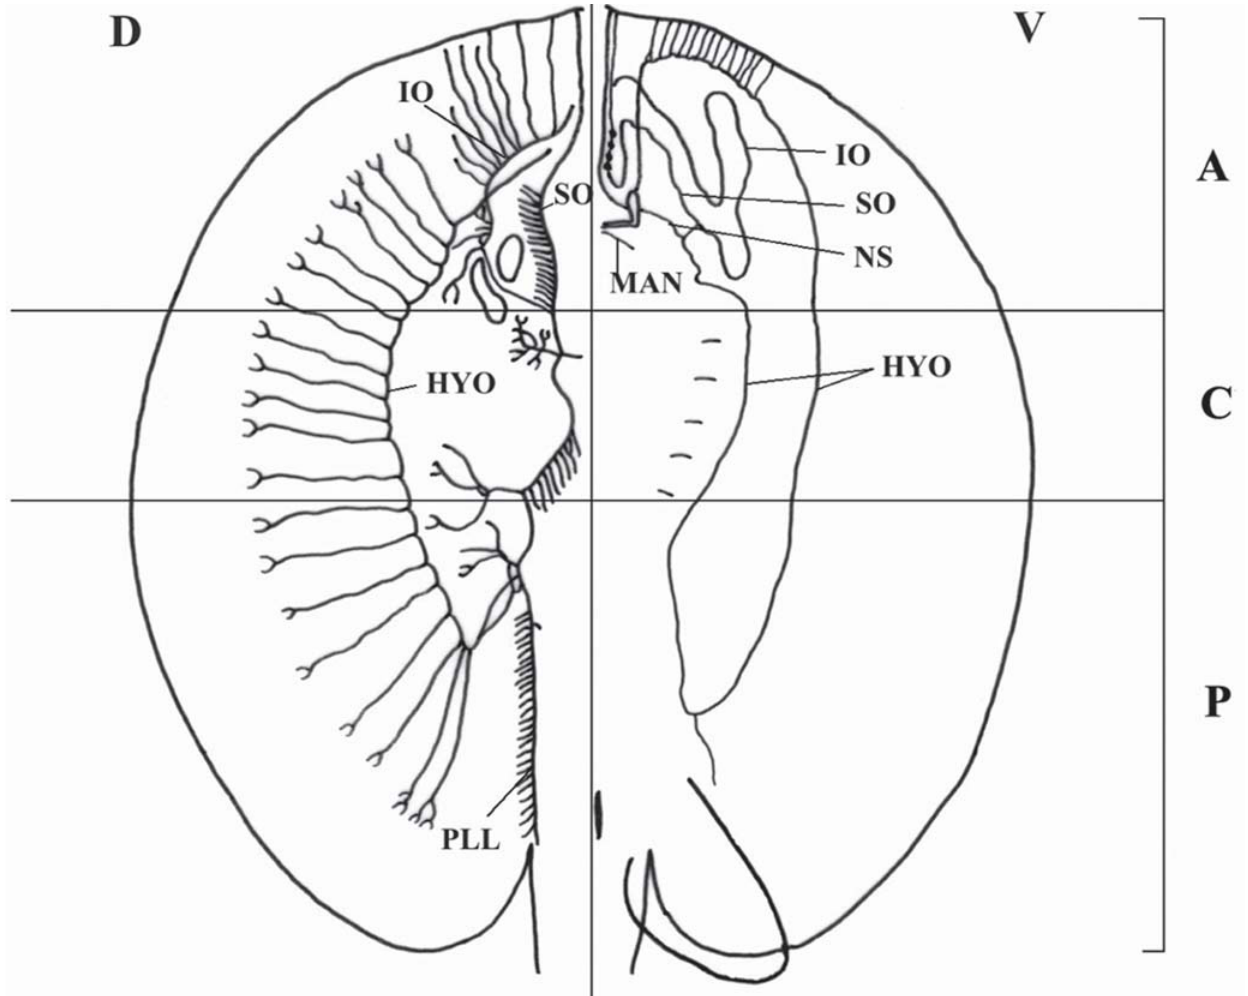
Fig. 2. Lateral line canals on the dorsal (D) and ventral (V) surfaces, divided in three sections to quantify neuromasts in Potamotrygon motoro and P . orbignyi . A) anterior; C) central, and P) posterior. HYO) hyomandibular canal; IO) infraorbital canal; MAN) mandibular canal; NS) nasal canal; PLL) posterior lateral line canal; SO) supraorbital